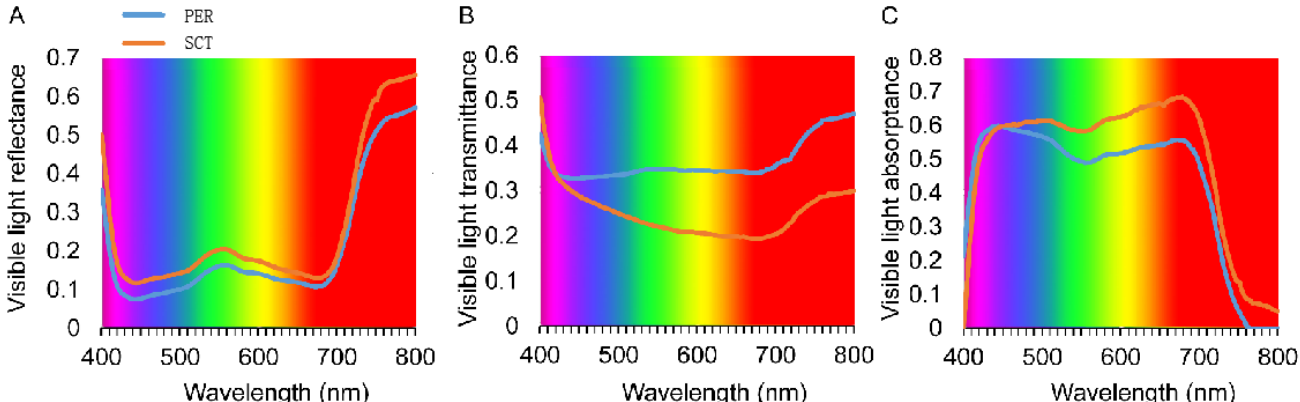
Figure 5. Spectral reflectance ( A ), transmittance ( B ), and absorptance ( C ) of the PER (pergola) and SCT (single-curtain training system) at veraison.